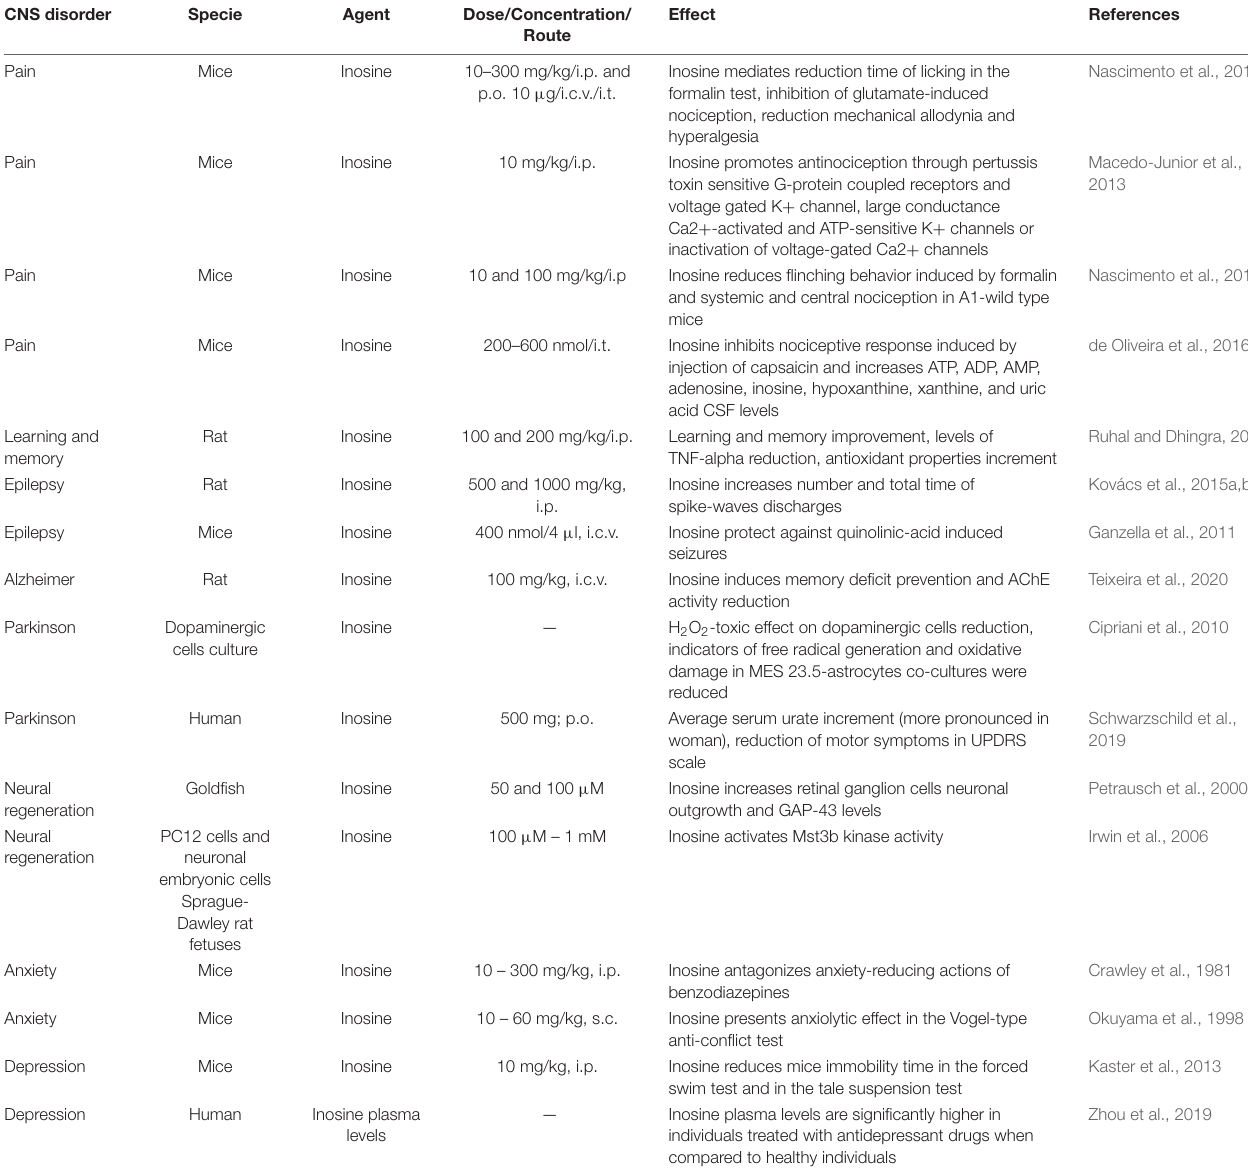
TABLE 1 | Summary of in vitro , preclinical and clinical studies that have demonstrated the therapeutic potential of inosine to treat neurological and psychiatric